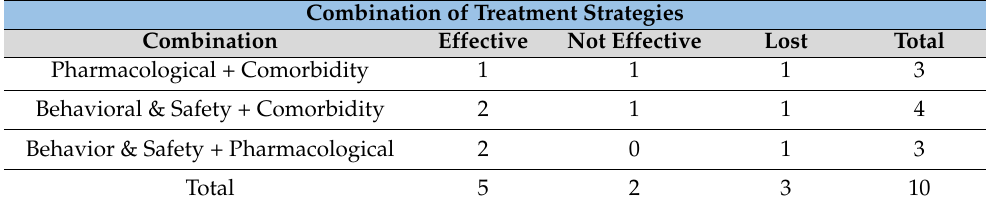
Table 2. Effectiveness of combinations of treatment strategies.